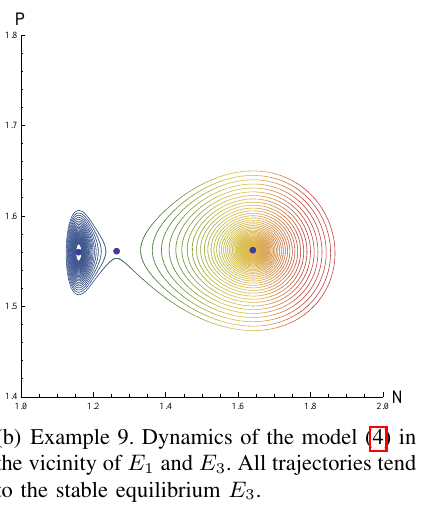
(a) Example 9. E 1 is unstable and E 3 is locally asymptotically stable; the thick dashed line separates the basin of attraction of E K .